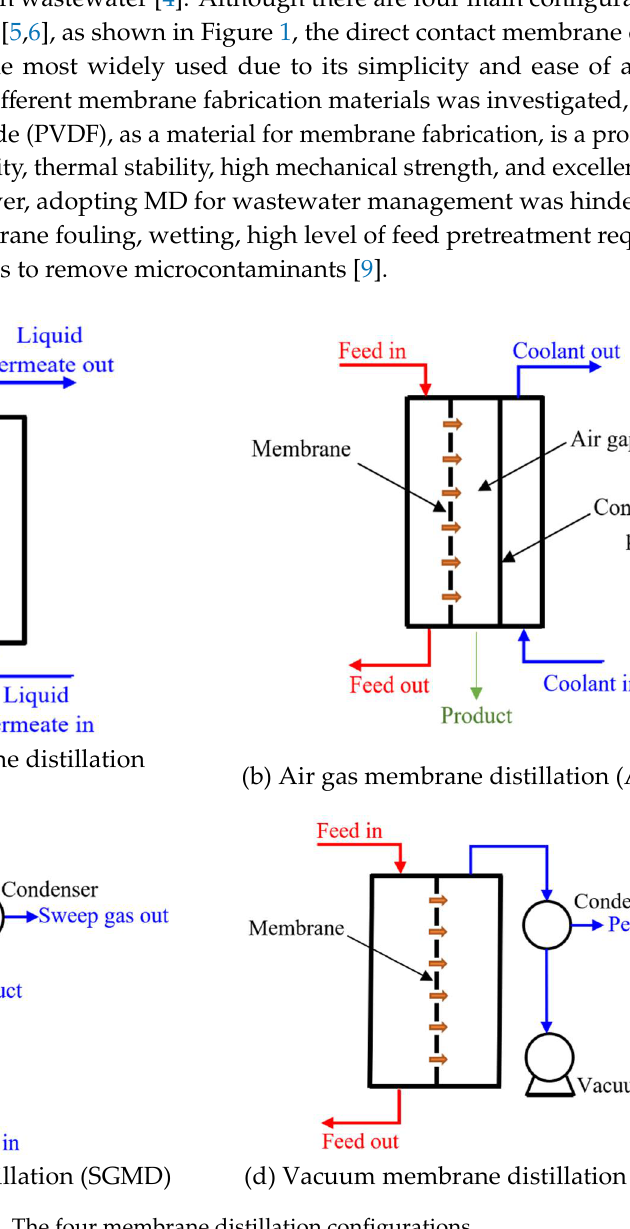
Figure 1. The four membrane distillation configurations.